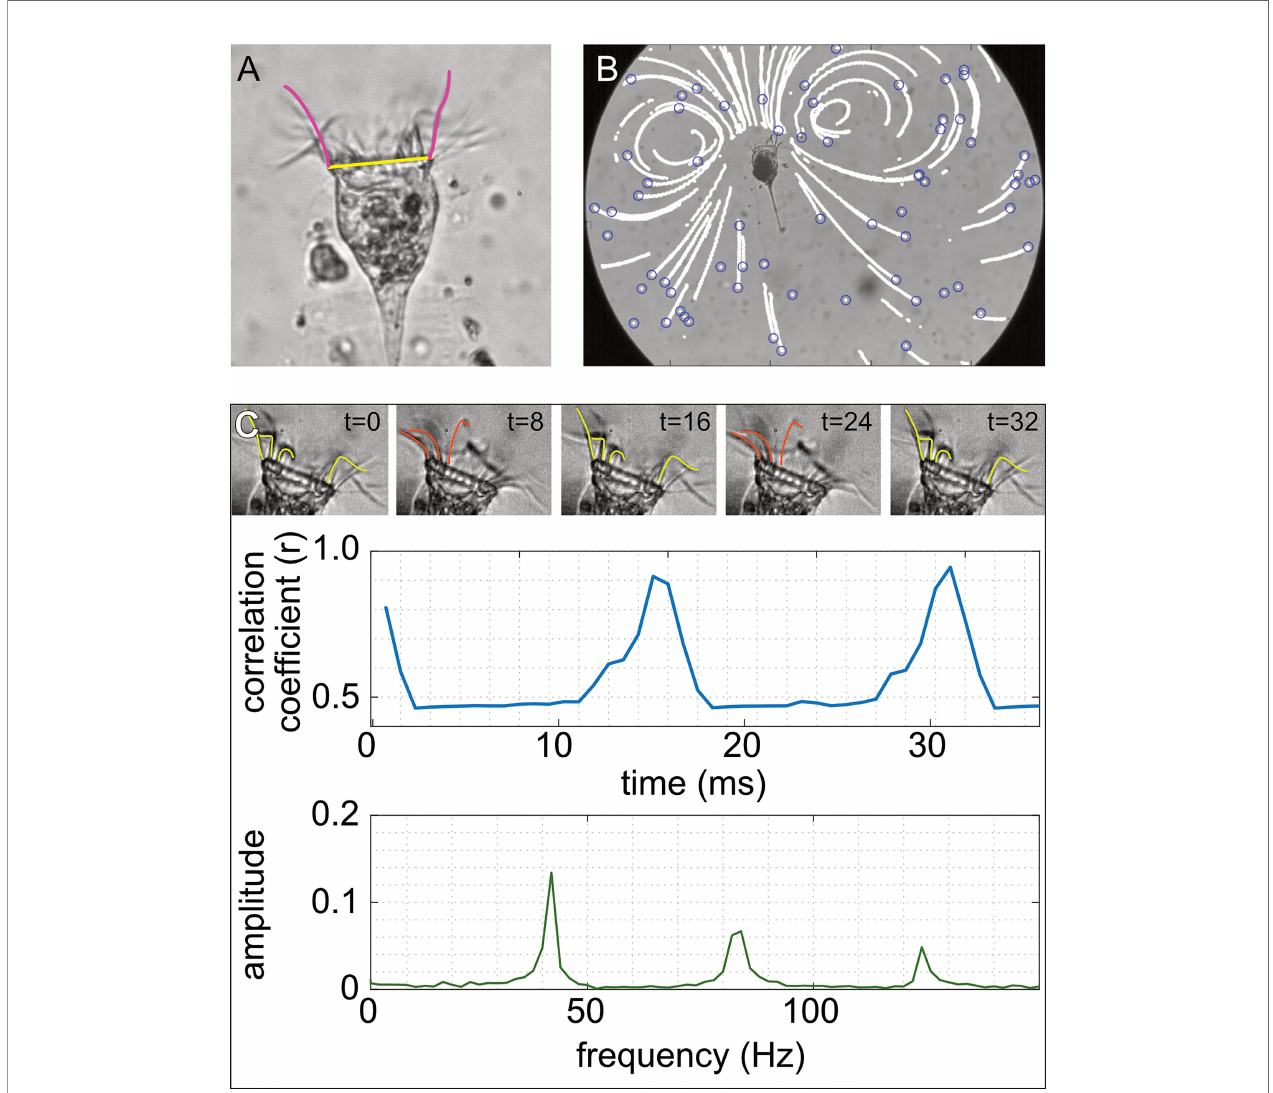
FIGURE 2 | Illustration of tintinnid morphology, particle velocity, and cilia beat frequency. (A) Oral diameter was measured from our videos as the distance between edges of the oral area (yellow line; 40 m m), and the length of the cilia was measured by drawing a line extending the length of the cilia when viewed at maximal length (pink line). (B) To estimate the fl ow speed, the position of the particles in the video (blue circles) was noted at each time step, which generated continuous movement tracks (white lines). (C) We took advantage of the repetitive arrangement of the cilia (upper panel in C ) to estimate their beat frequency. We correlated the brightness values of pixels in the cilia area at t = 0 (left panel in C ) to those in consecutive frames (middle and right panels in C ). This correlation coef fi cient peaks when the cilia return to their reference arrangement. Fast Fourier transform (FFT) was used on the vector of correlation coef fi cients to extract the dominant frequency, which represents the cilia beat frequency (lower panel in C ). Photos and drawings are for Climacocilys scalaria